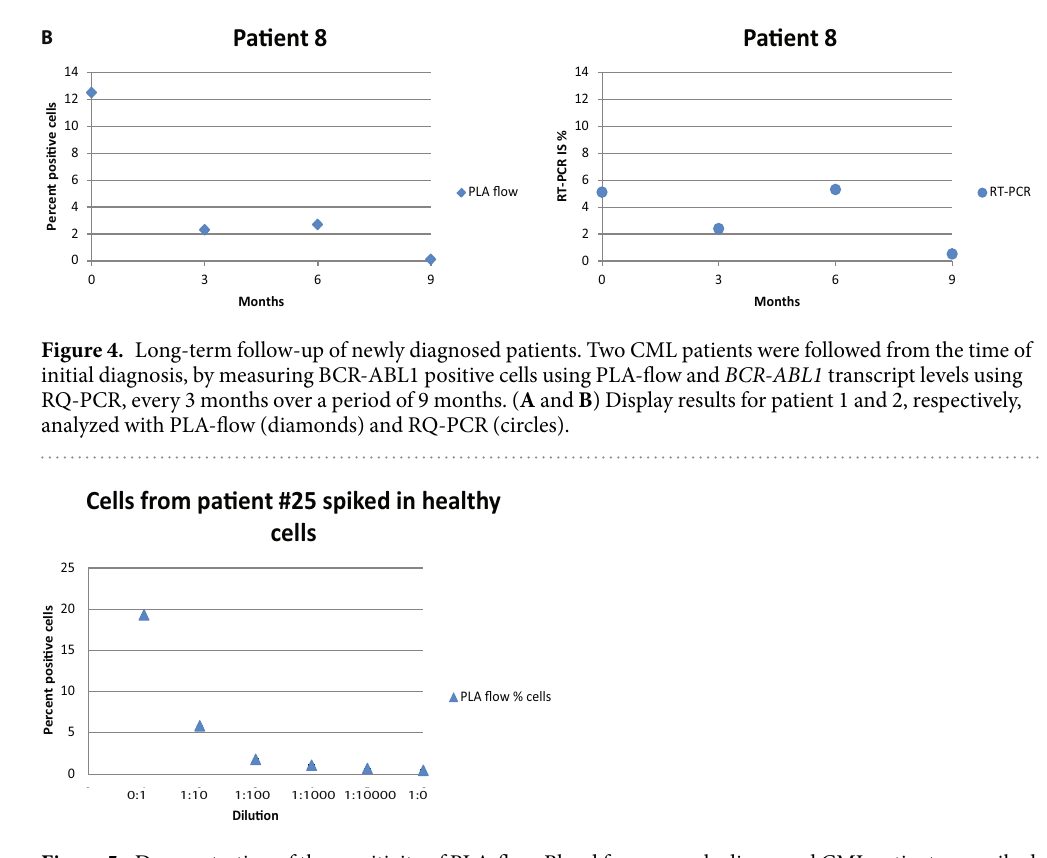
Figure 5. Demonstration of the sensitivity of PLA-flow. Blood from a newly diagnosed CML patient was spiked in blood from a healthy individual in a ten-fold dilution series. Samples were analyzed with PLA-flow to detect positive cells expressing the fusion protein BCR-ABL1. The X-axis indicates the dilutions, while the Y-axis displays percentages of cells expressing BCR-ABL1. Error bars represent standard deviation